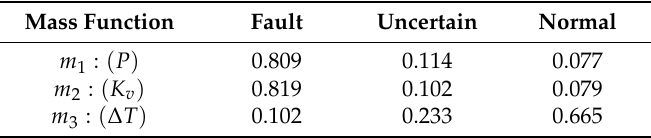
Figure 8. The waveform of outer ring fault bearing vibration signal. ( a ) Time domain waveform; ( b ) envelope spectrum waveform.